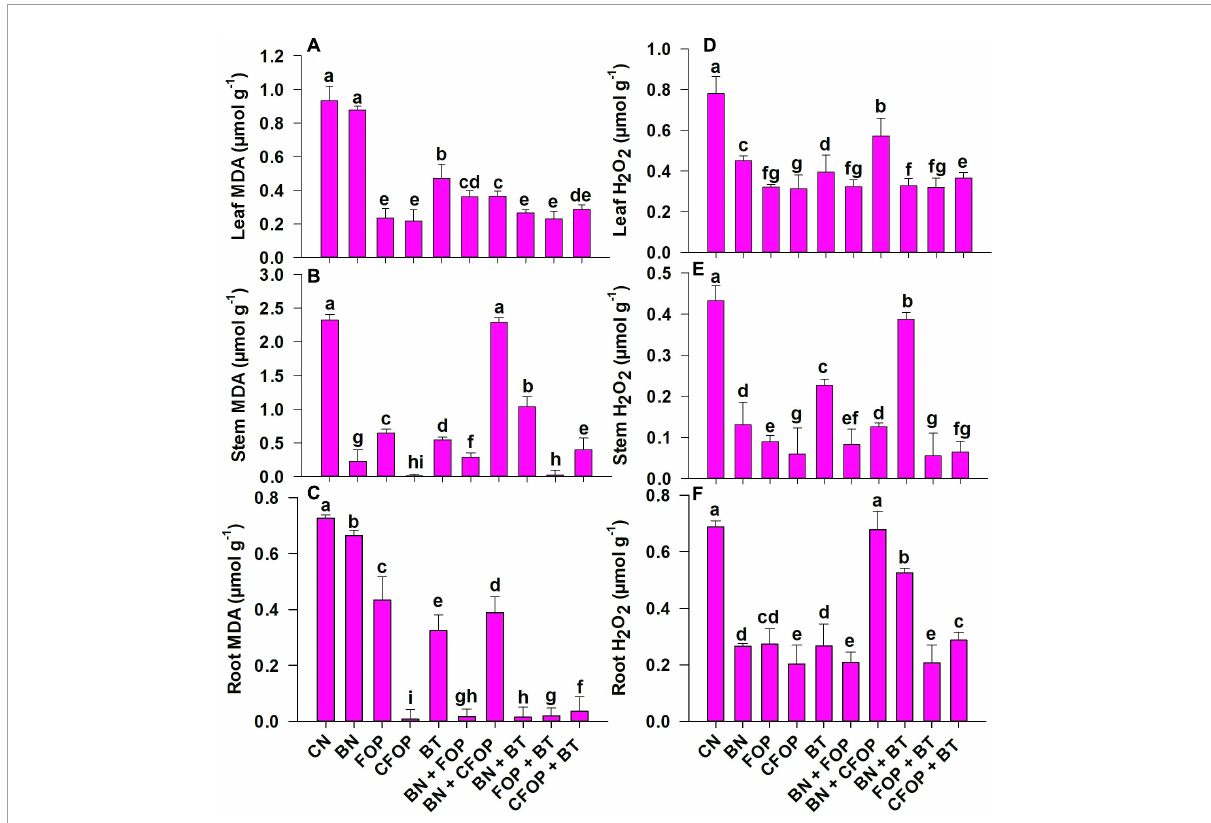
FIGURE4 Malondialdehyde (MDA) and hydrogen peroxide (H 2 O 2 ) concentrations in leaves (A,D) , stem (B,E) and root (C,F) of brinjal plant ( Solanum melongena ) as affected by various treatments: Control (CN); bentonite (BN); Iron oxide nanoparticles (FOP); Cerium-doped iron oxide nanoparticles (CFOP); Azotobacter nigricans sp. (BT); BN + FOP; BN + CFOP; BN + BT; FOP + BT; T10 = CFOP + BT. At ( P < 0.05) column with changed letters are significantly